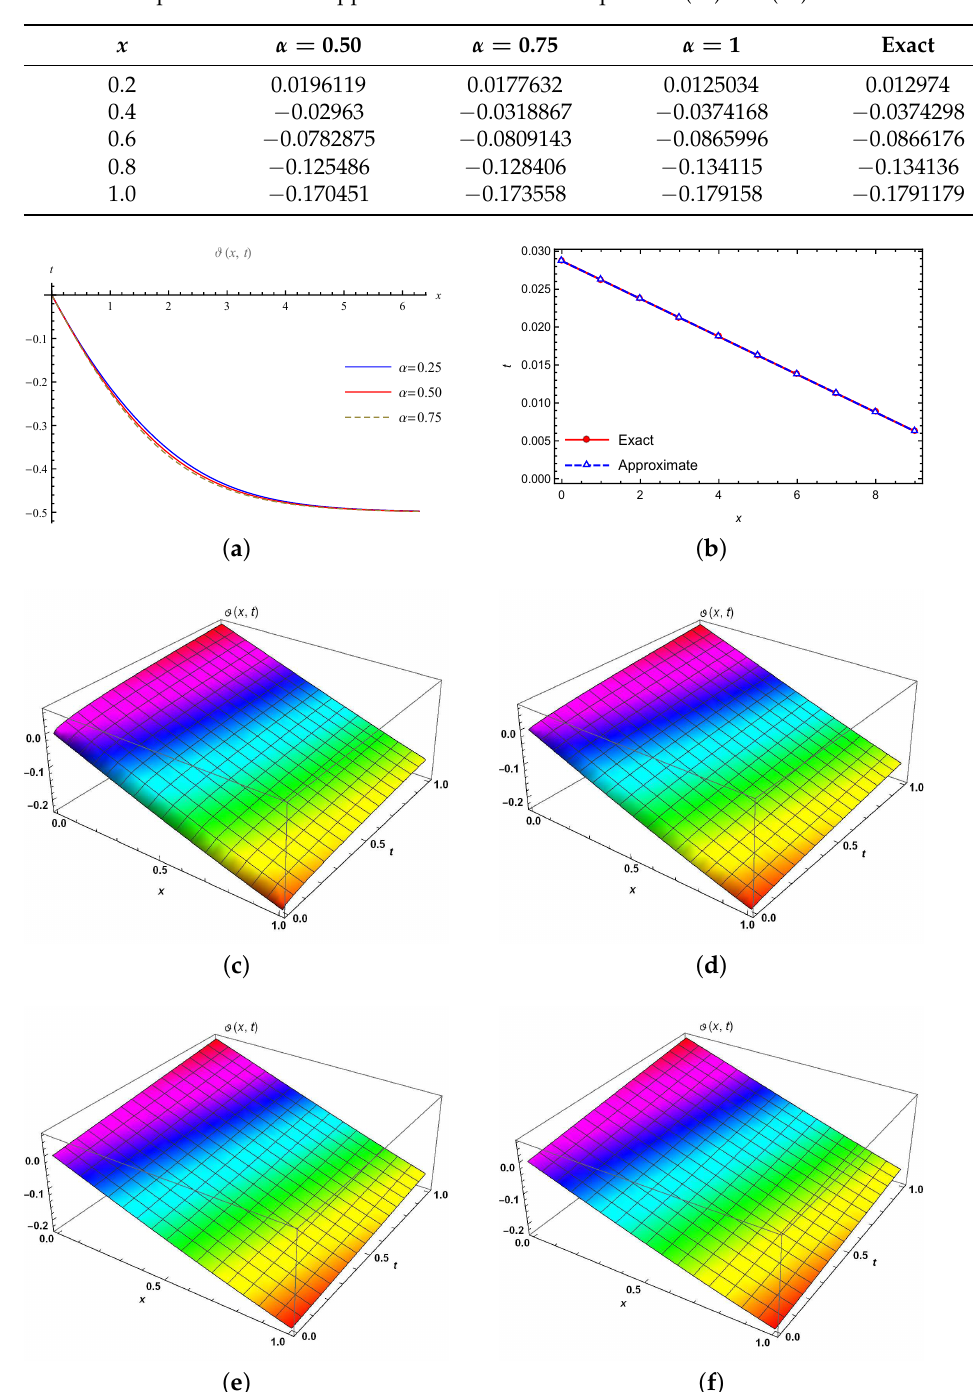
Table 2. Comparison between approximate solutions of Equations (17) and (18) when t = 0.5.